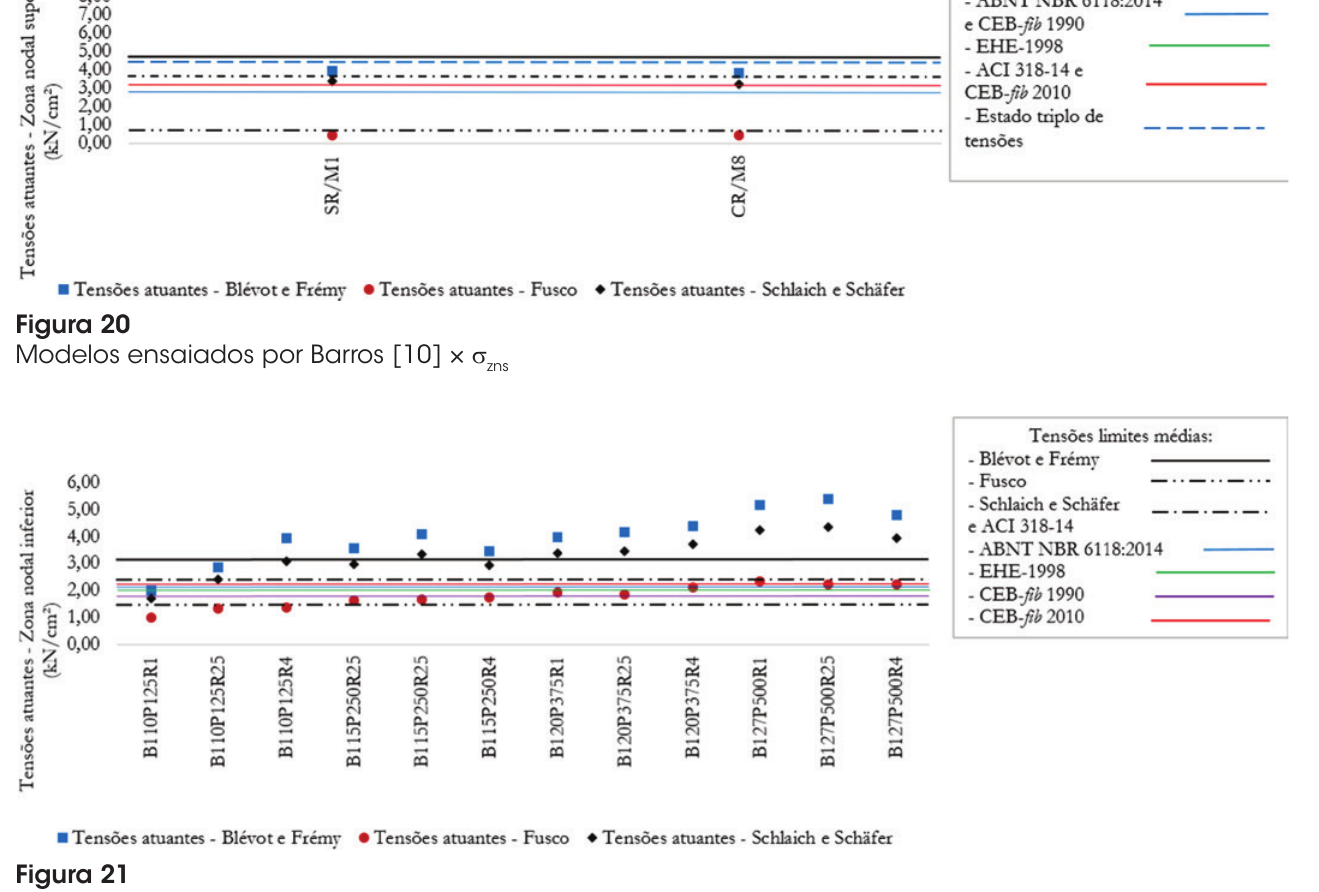
Modelos ensaiados por Munhoz [11] × σ